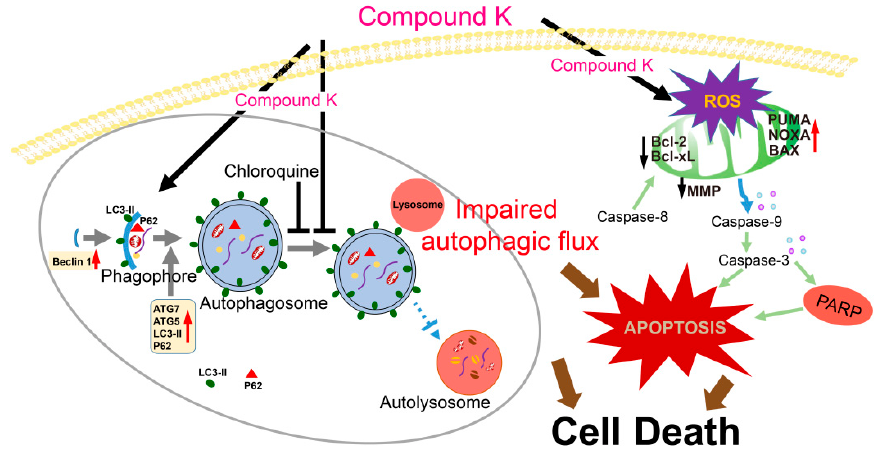
Figure 9. Schematic representation of the proposed mechanisms of CK-induced apoptosis in neuroblastoma cells. CK induced caspase-dependent apoptosis and ROS generation and inhibited autophagy flux. Importantly, ROS scavenger NAC markedly blocked CK-induced ROS generation and apoptosis. Moreover, chloroquine, an autophagy flux inhibitor, augmented the CK-induced apoptosis, mitochondrial ROS generation. Altogether, a combination treatment of CK with chloroquine, a pharmacological inhibitor of autophagy, may be a novel therapeutic potential for the treatment of neuroblastoma.